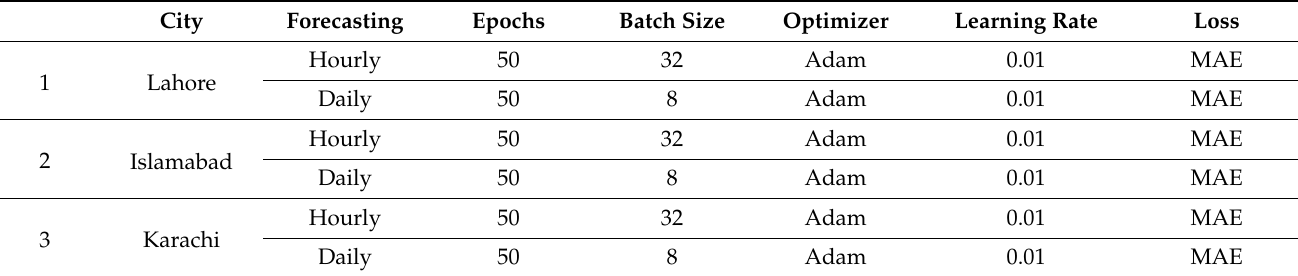
Table 4. Parameters used for training of the daily and hourly multivariate LSTM